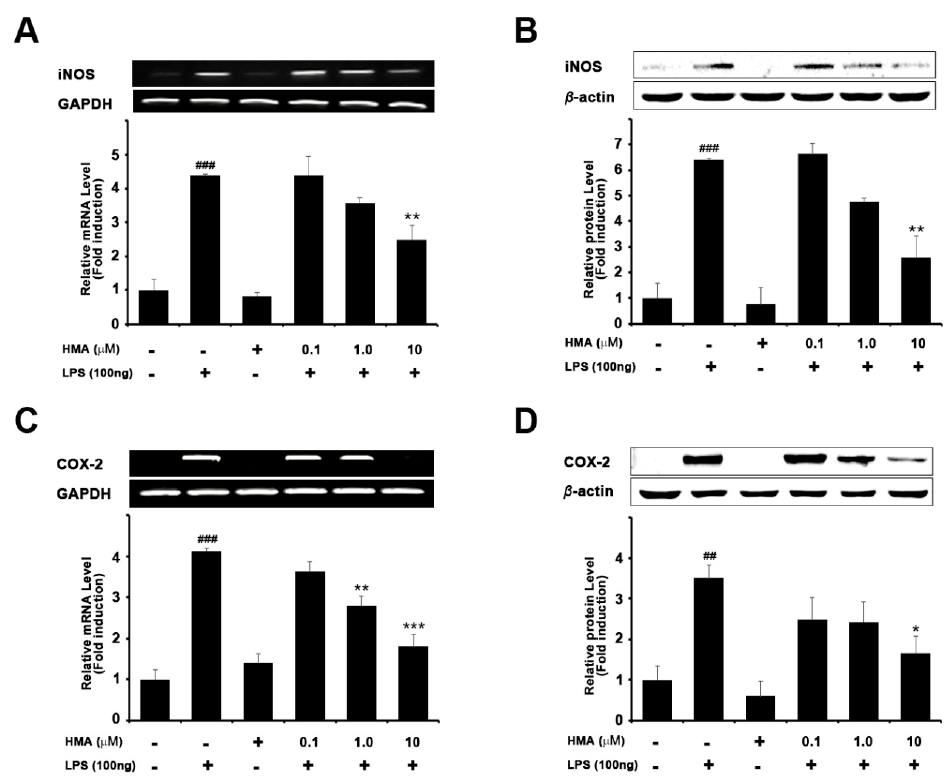
Figure 2. Effect of HMA on iNOS and COX-2 expression in LPS-stimulated BV-2 microglia cells. BV-2 cells were treated with different concentration of HMA (0.1, 1, and 10 μ M) for 60 min before incubating with LPS (100 ng/mL) for 6 h (RT-PCR) or 18 h (immunoblot). ( A , B ) mRNA and protein expression of iNOS; ( C , D ) mRNA and protein expression of COX. Relative expression levels (fold) of iNOS and COX-2 were normalized to that of GAPDH and β -actin for RT-PCR and immunoblotting analysis, respectively. Data are mean ± S.E.M. (n = 3) performed in three independent experiments. ### p < 0.001 as compared with the control group; * p < 0.05, ** p < 0.01, and *** p < 0.001 as compared with the LPS-treated group by one-way ANOVA. ( A ) F(5,12) = 23.81, p < 0.0001; ( B ) F(5,12) = 24.33, p < 0.0001; ( C ) F(5,18) = 31.79, p < 0.0001; ( D ) F(5,18) = 6.576, p = 0.0012).